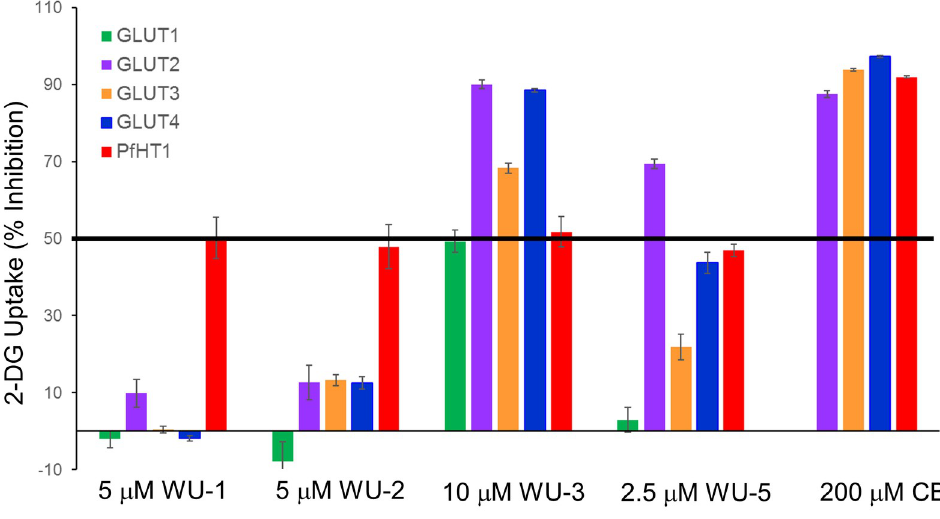
Fig 2. Specificity of hit compounds for PfHT over class I human orthologues. Uptake of 2-DG by HEK293 cells overexpressing hGLUT1-4 in the presence of the indicated compounds at indicated concentrations approximating their IC 50 for PfHT as shown in Fig 1. CB was used as a positive